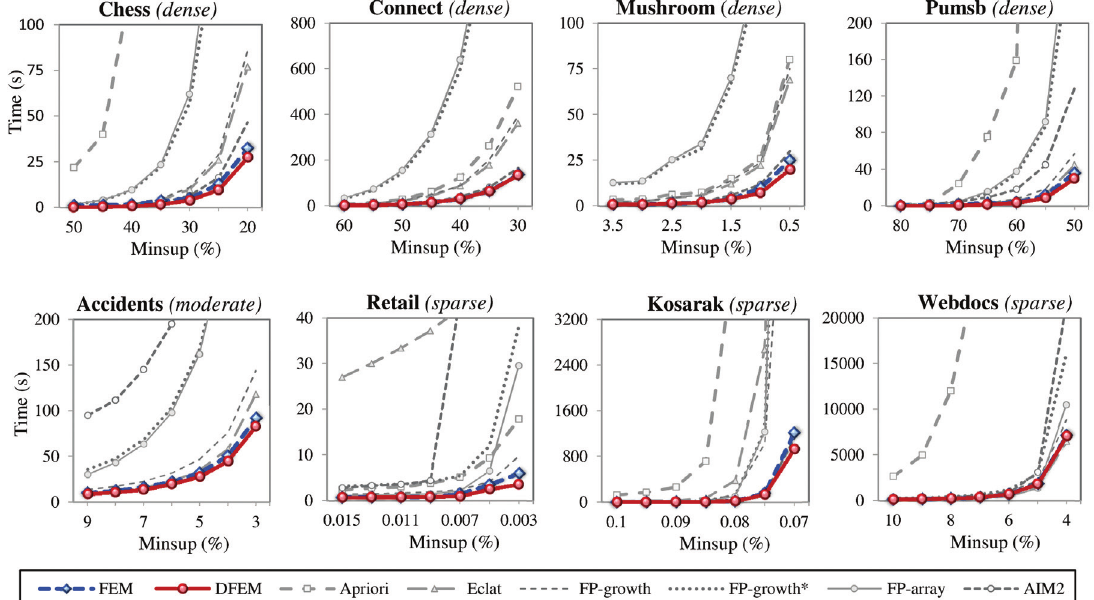
Figure 12. Execution Time of FEM, DFEM, and Other